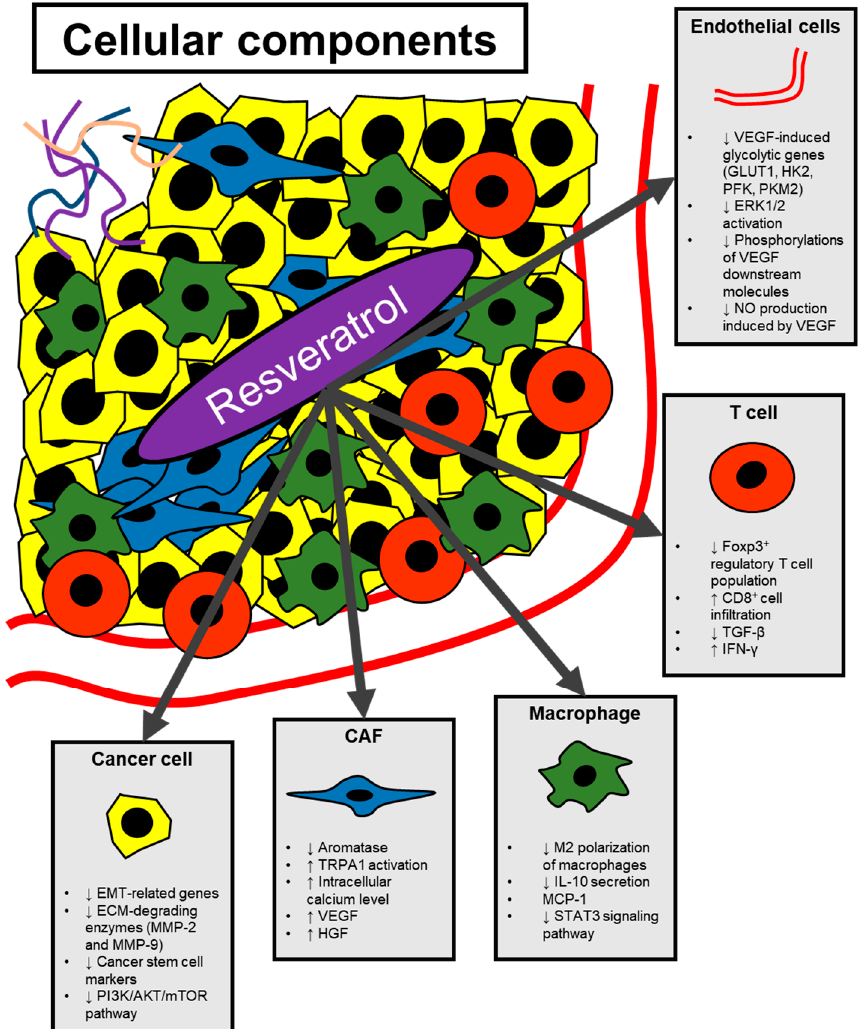
Figure 2. The effect of resveratrol on cells composing the tumor microenvironment. Cellular composition of tumor microenvironment affects cancer progression and oncogenic signaling. The effect of resveratrol on various cell types (cancer cells, CAFs, macrophages, T cells and endothelial cells) in the tumor microenvironment is displayed.